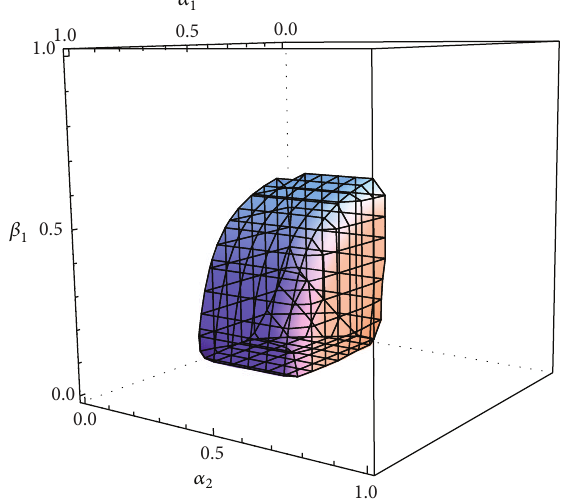
Figure 1: The local stable region with 𝛽 2 = 0.34 .